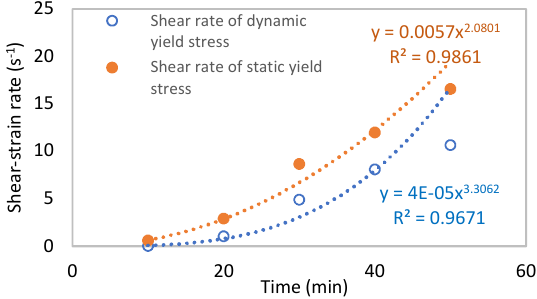
Figure 11. Correlation between the shear-strain rate range and time. Figure 11. Corrеlation bеtwееn the shеar-strain ratе rangе and timе. Figure 11. Corrеlation bеtwееn the shеar-strain ratе rangе and timе.